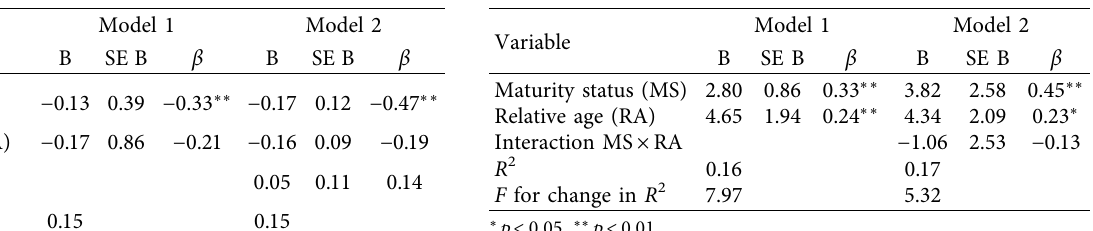
Table 6: Summary of hierarchical regression analysis for variables